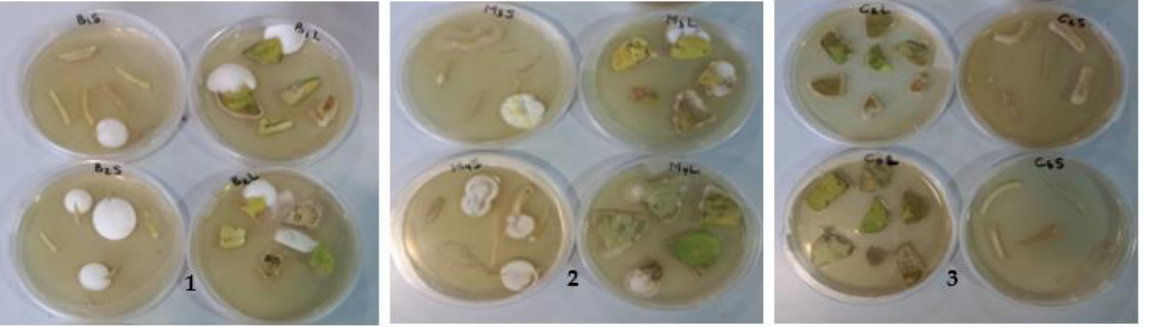
Figure 1. Re-isolation of EPFs from cucumber seedlings (1. B. bassiana , 2. M. anisopliae , and 3. Control treatments).